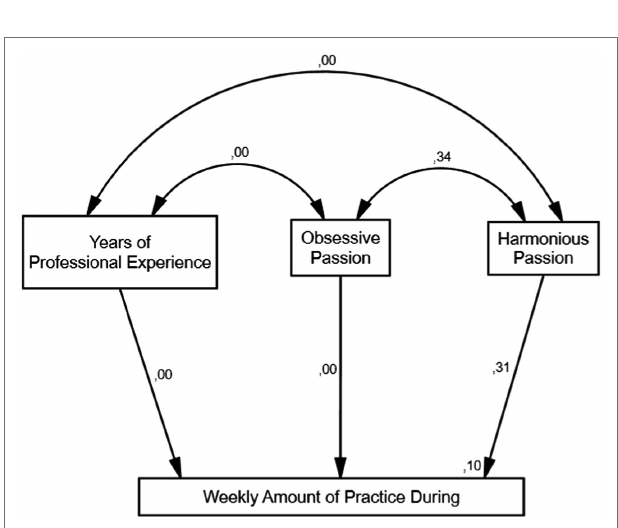
FIGURE 3 | Model during the COVID-19 pandemic for Latin